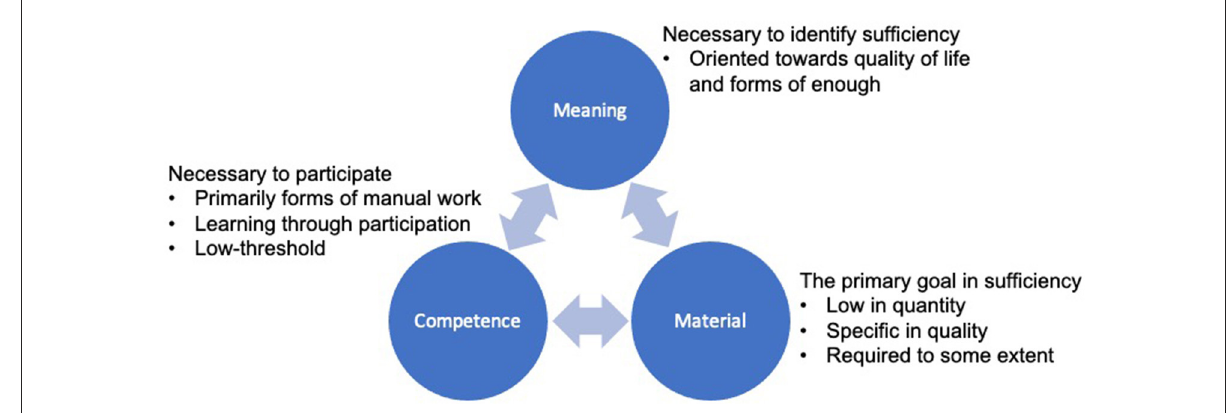
FIGURE1 Locations of sufficiency in social practices (own